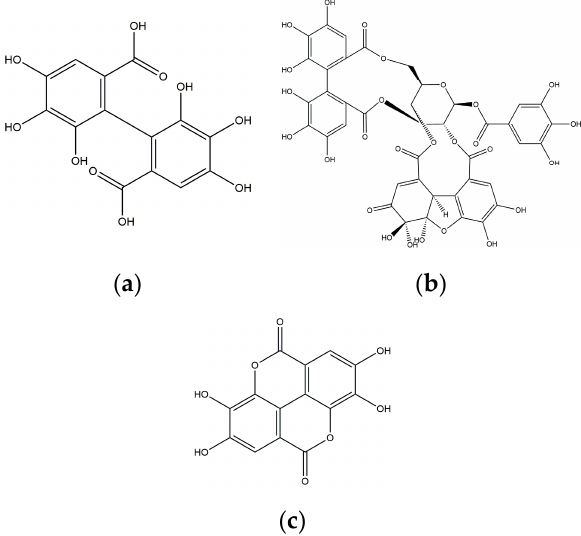
Figure 1. ( a ) HHDP (Hexahydroxydiphenic acid) group, the particular group of ellagitannins; ( b ) geraniin, an ellagitannin; ( c ) ellagic acid, a compound derived from ellagitannins.